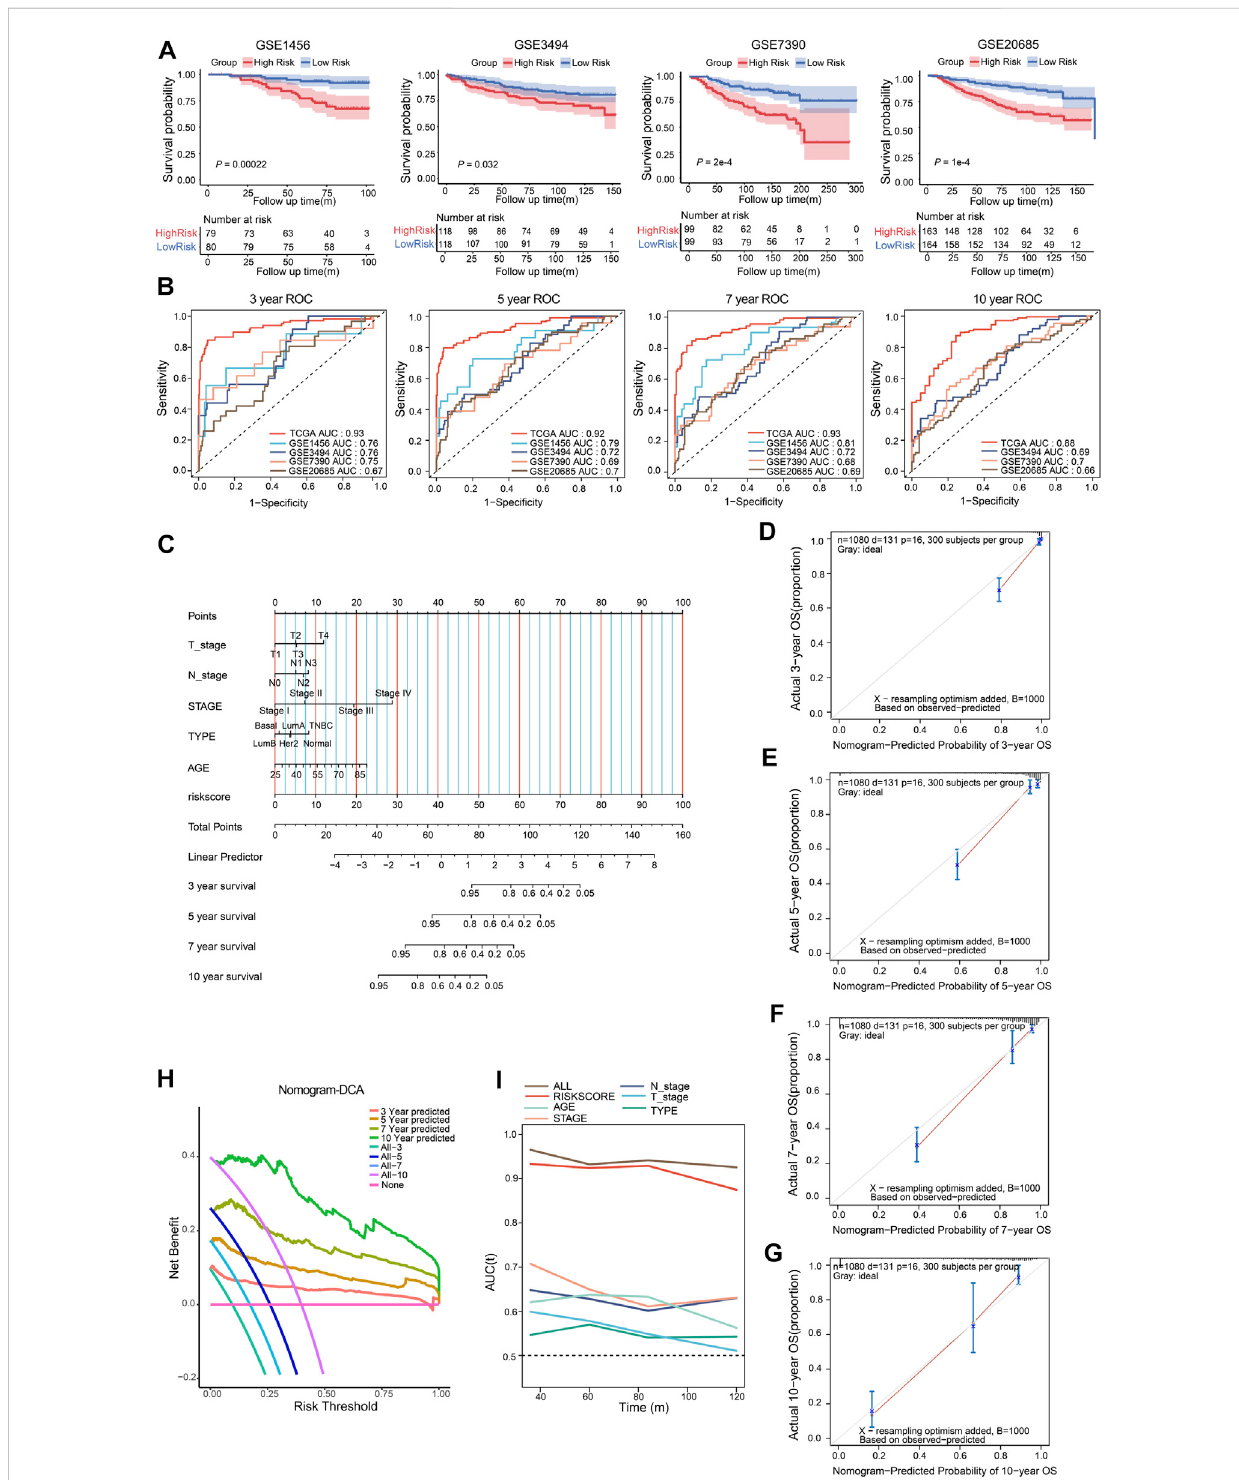
FIGURE 4 Validation of the CSRGs risk model, conduction and validation of nomogram in BRCA patients. (A) The Kaplan – Meier curves illustrated the survival probabilitybetweenhigh-riskandlow-riskgroupsinGSE1456,GSE3494,GSE7390andGSE20685datasets. (B) TheROCanalysisshowedtheAUCfor3-, 5-, 7- and 10- year survival in the training dataset and testing datasets. (C) The nomogram was established by incorporating clinical parameters and the riskscoretopredicttheprobabilityof3-,5-,7-and10-yearsurvivalforbreastcancerpatients. (D – G) Calibrationplotofthenomogramdisplayedthe actual and predicted survival outcome for 3- (D) , 5- (E) , 7- (F) and 10-year (G) . (H) DCA of the nomogram for 3-, 5-, 7- and 10- year survival bene fi t; the straight line represents the assumption that no patients died; the wavy lines represent predictive survival; the curve lines represent actual survival. (I) The time-dependent ROC analyzed AUC for the predictive value compared nomogram with other parameters in BRCA